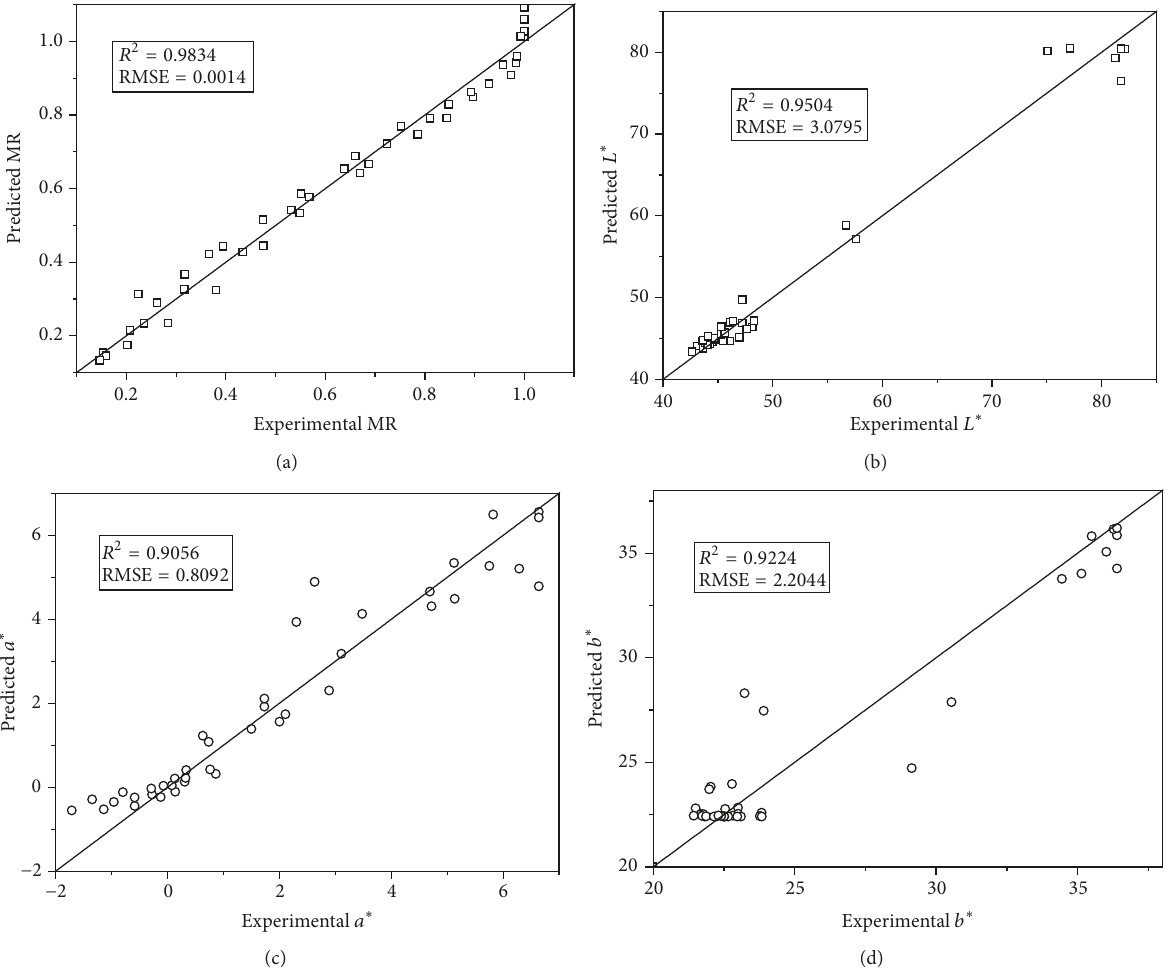
Figure 5: Comparison of predicted and experimental moisture ratio and color parameters ( 𝐿 ∗ , 𝑎 ∗ , and 𝑏 ∗ ) on testing step for the optimal ANN